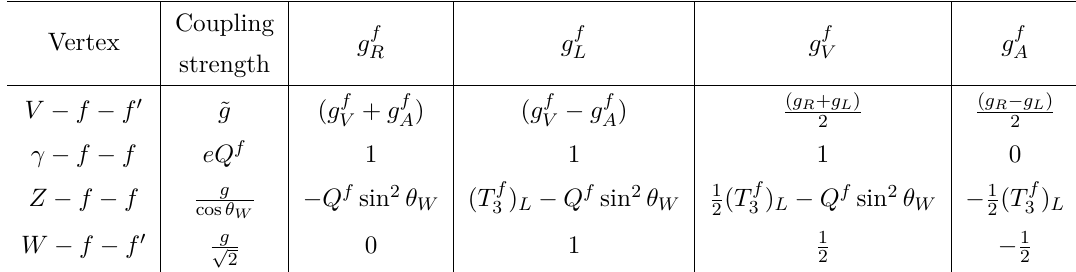
) = ± 1 / 2 and electric charge Q f , with normalization Q ‘ = − 1 L 3